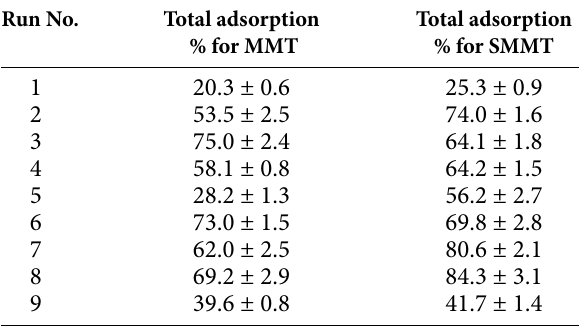
Table 2. Batch adsorption test results based on the Taguchi design with the two adsorbents: MMT and SMMT Run